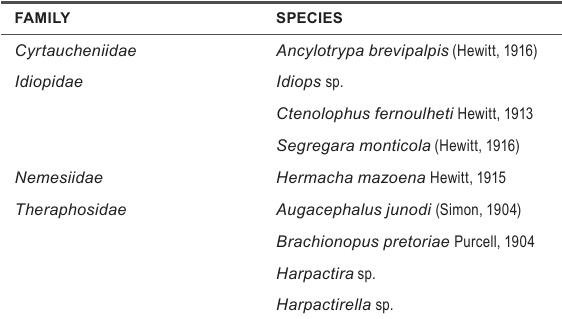
Table 3 Checklist of the mygalomorphs of the Polokwane Nature Reserve, Limpopo Province, South Africa